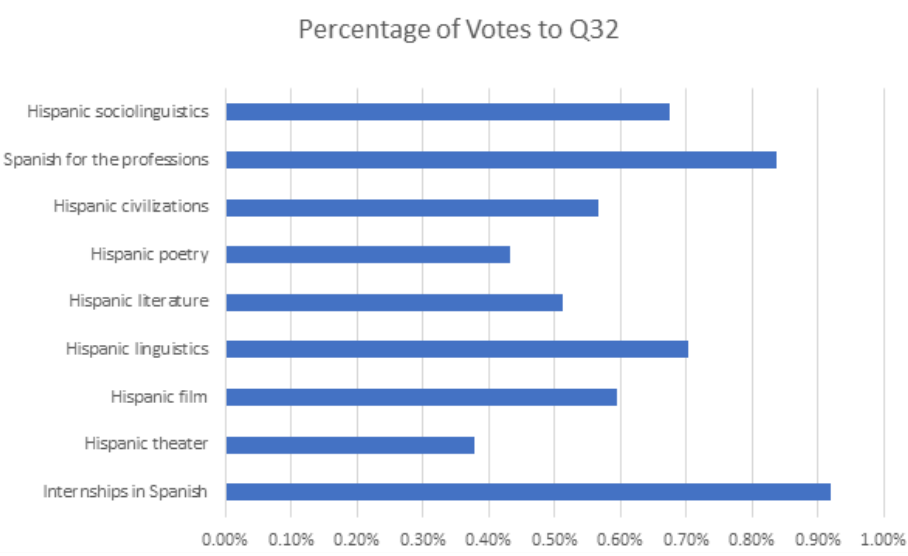
Table 2: Percentage of Votes to Q32: “I would love to see the following classes offered by the Spanish Program (Check all that